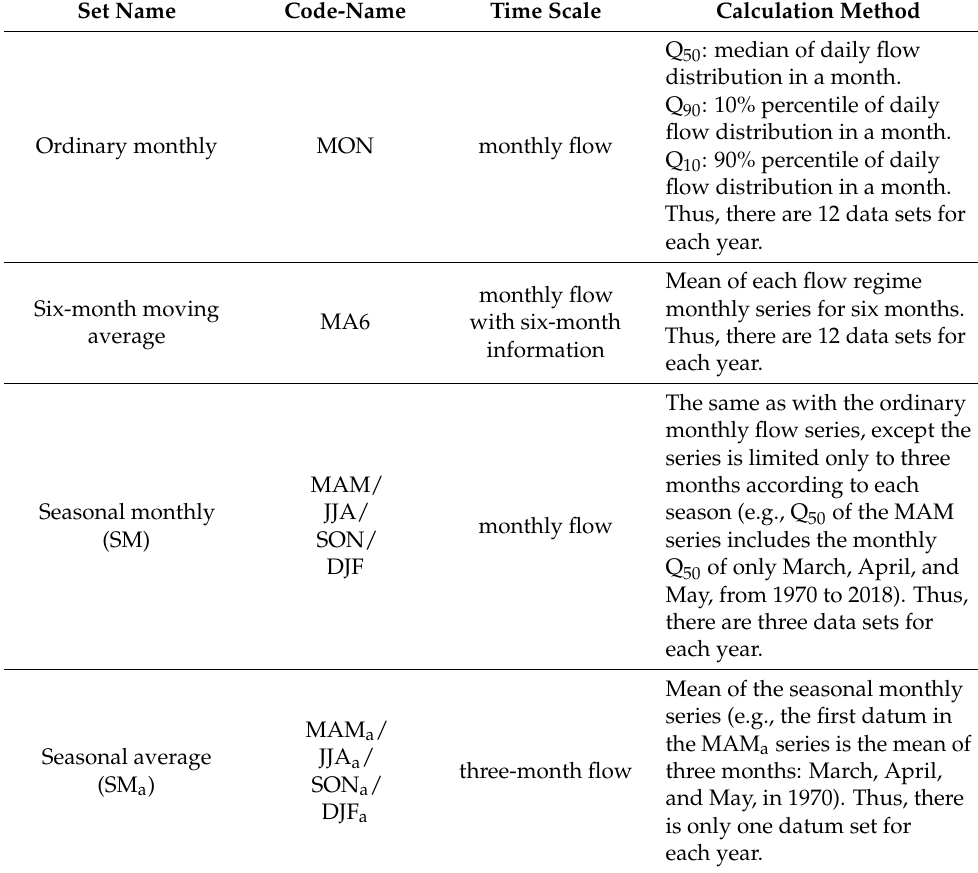
Table 2. Temporal variation sets calculation